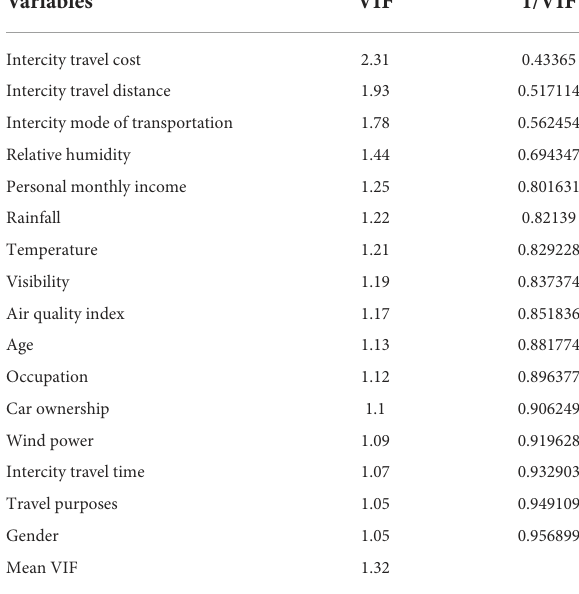
TABLE 7 Multicollinearity test